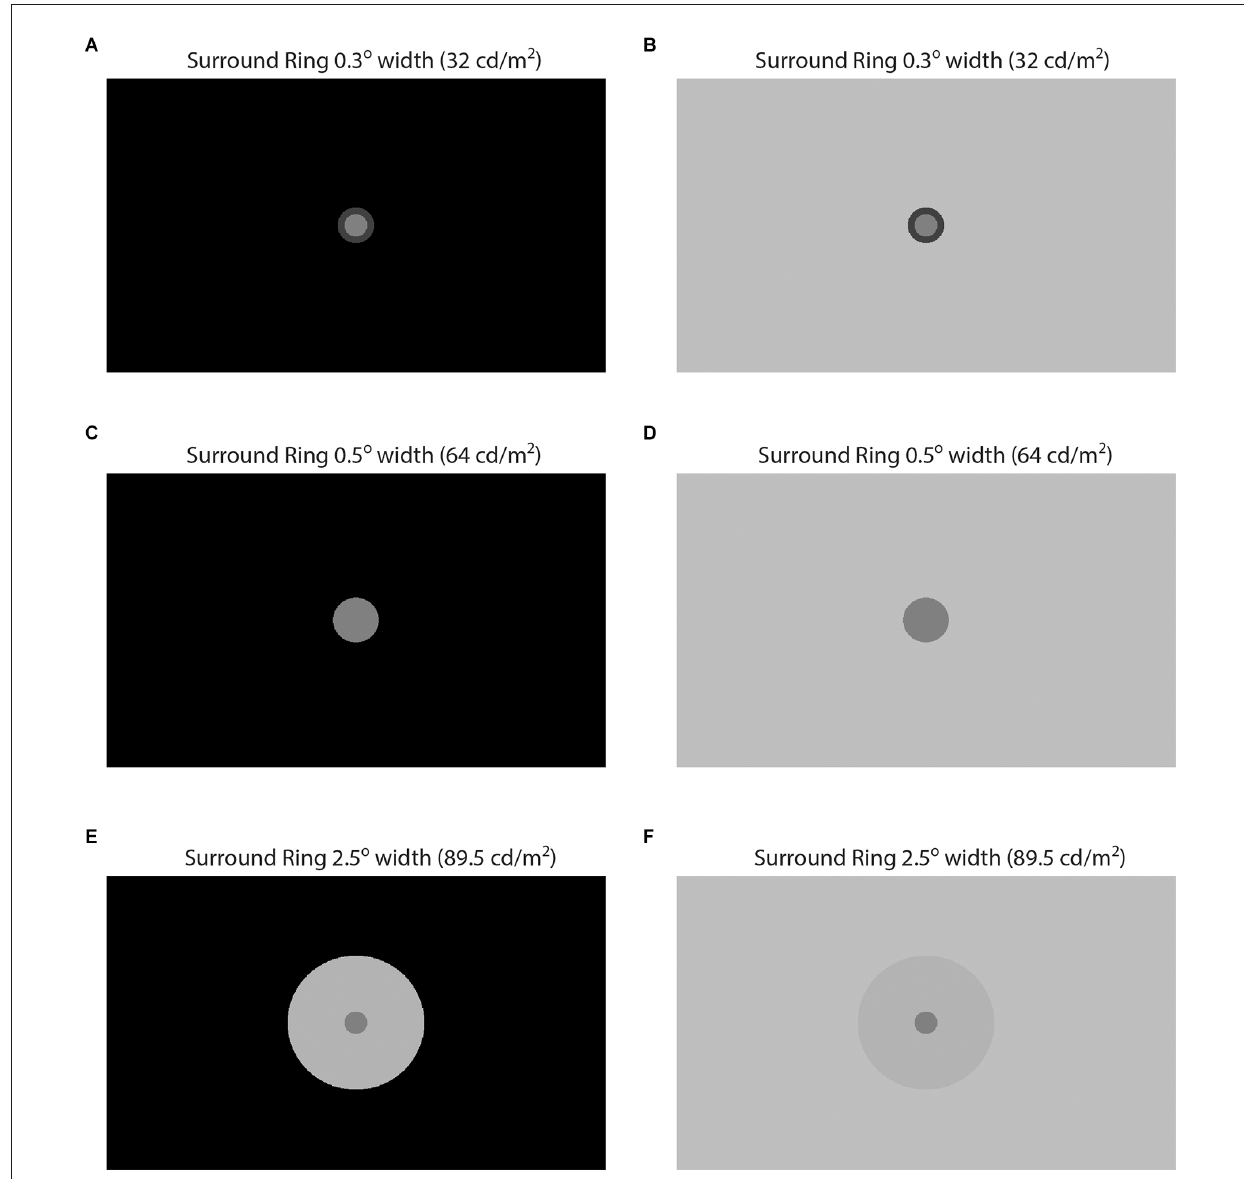
FIGURE2 Illustration of some of the brightness induction stimuli from Experiment 2. In (A–F) target patch luminance is 64 cd/m 2 and target patch radius is 0.5 ◦ . In (A,C,E) the remote background is 0.0 cd/m 2 and in (B,D,F) the remote background is 96 cd/m 2 . The adjacent surround-ring varies in luminance and width but is identical for pairs (A,B) , (C,D) , and (E,F) . In pair (A,C) the adjacent surround-ring is 0.3 ◦ in width and its luminance is 32 cd/m 2 . In pair (C,D) the adjacent surround-ring is 0.5 ◦ in width and its luminance is 64 cd/m 2 . Since the target patch and the adjacent surround-ring have the same luminance in this pair they are not distinguishable, and the stimulus reduces to a circular patch with a radius of 1 ◦ . In pair (E,F) the adjacent surround-ring is 2.5 ◦ in width and its luminance is 89.5 cd/m 2 .